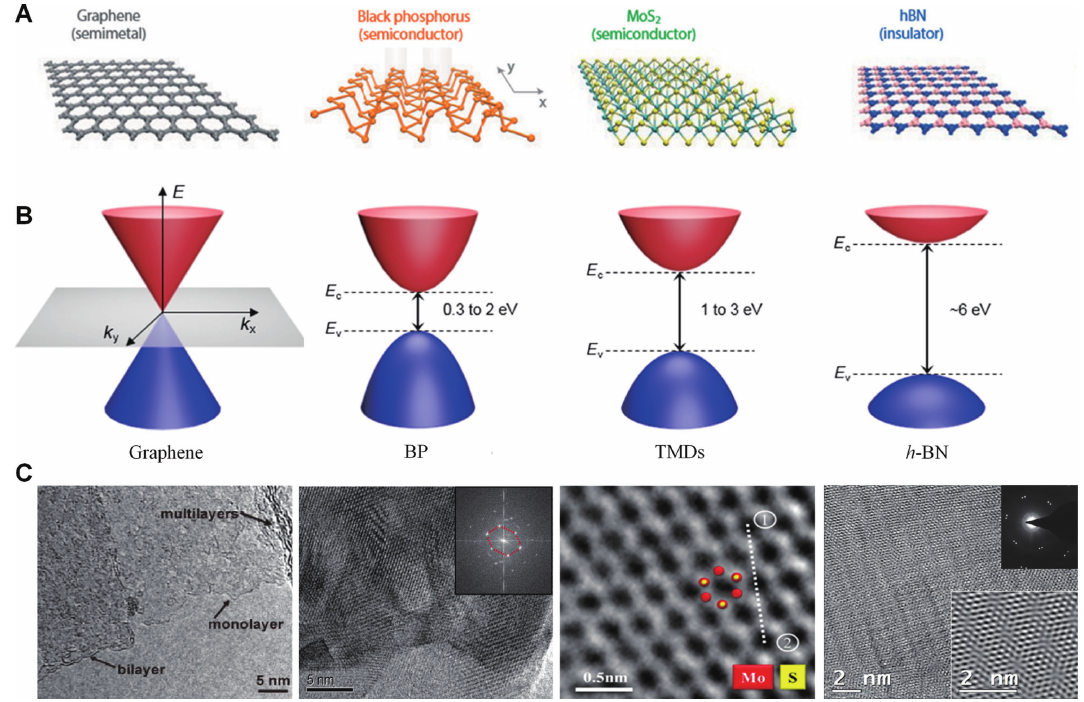
Figure 1: Structures and photographs of representative nanomaterials. (A) Atomic crystal structures, (B) electronic band structures, and (C) TEM images of graphene, BP, TMDs, and h-BN. (A) and (B) Adapted